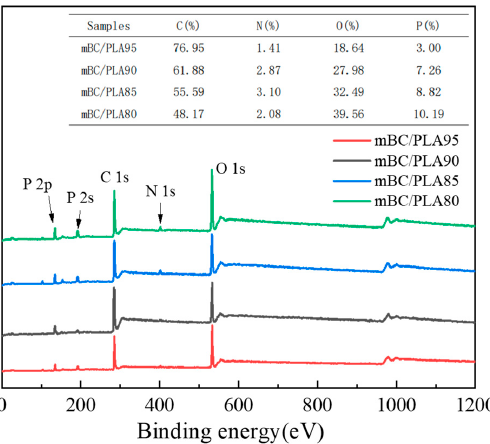
Figure 11. XPS results of residual carbon from cone-tested composites.